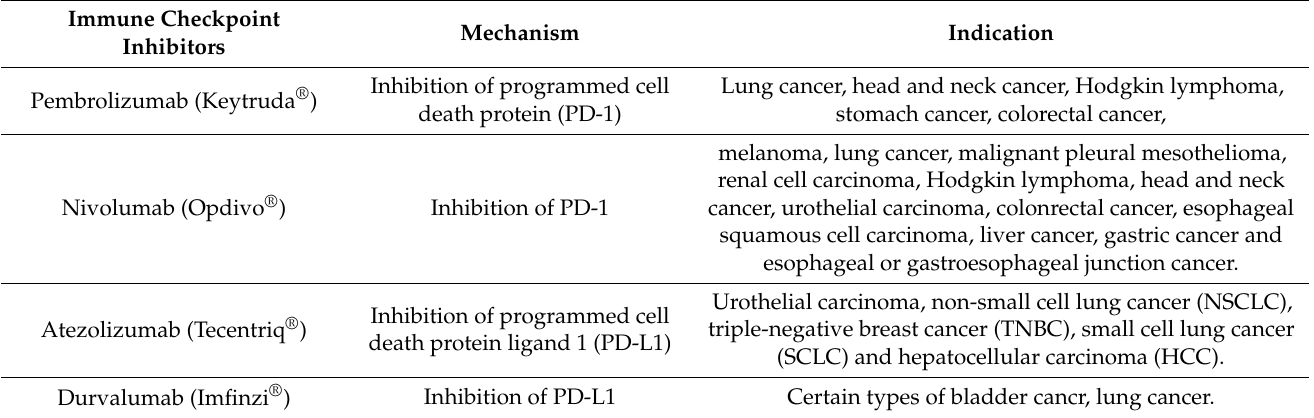
Table 1. The monoclonal antibodies approved by the U.S. FDA to be used as immune checkpoint inhibitor for immunother- apy related to lung cancer or colorectal